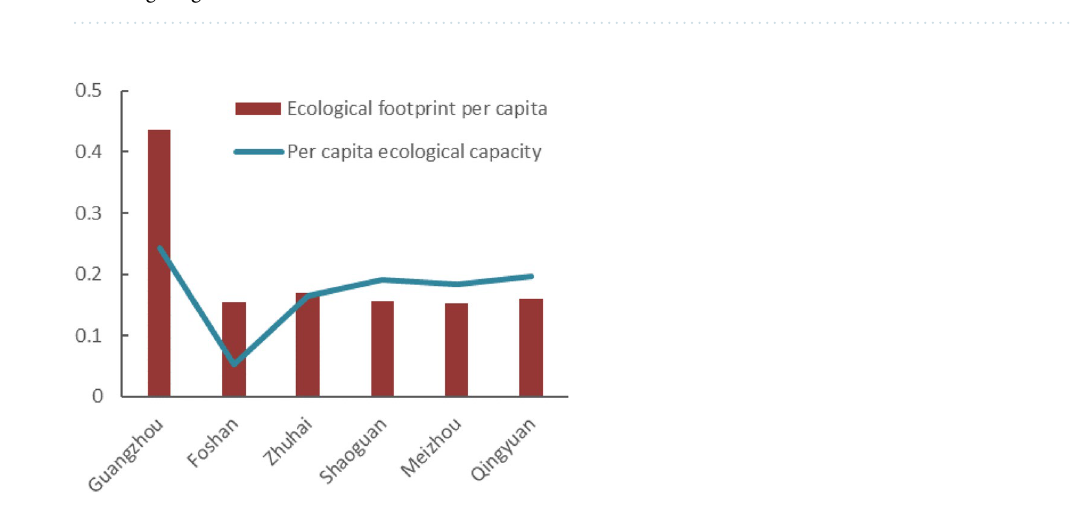
Figure 6. Dynamic changes of per capita ecological footprint, ecological carrying capacity and ecological deficit in Guangdong Province from 2013 to 2018.